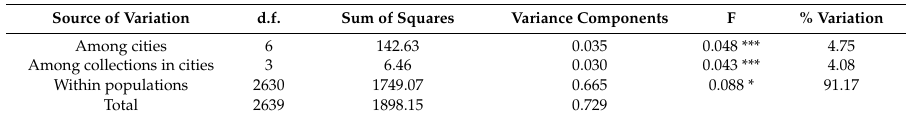
Table 1. Analysis of Molecular Variance (AMOVA) of allele frequencies among 10 populations of Aedes aegypti in Sri Lanka. Source of Variation d.f. Sum of Squares Variance Components F % Variation Among cities 6